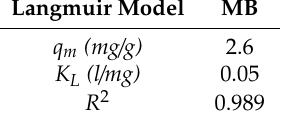
Table 3. The values of Langmuir parameters obtained using a non-linear method for MB adsorption onto PAN/goethite CNF.